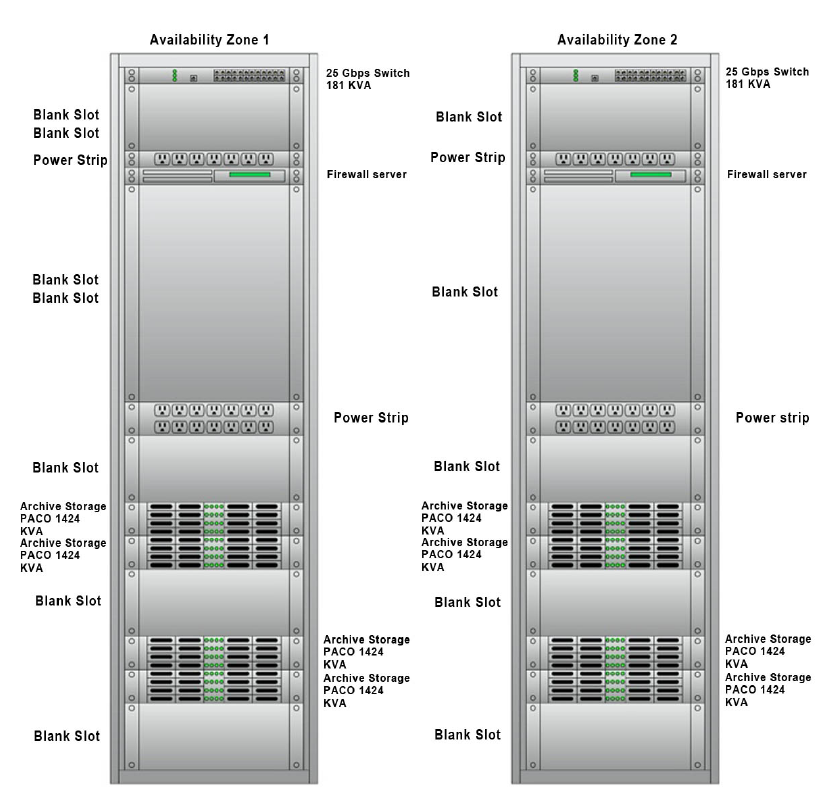
Figure 4. Phase 1 Space and Power Needs are Shown in the Rack